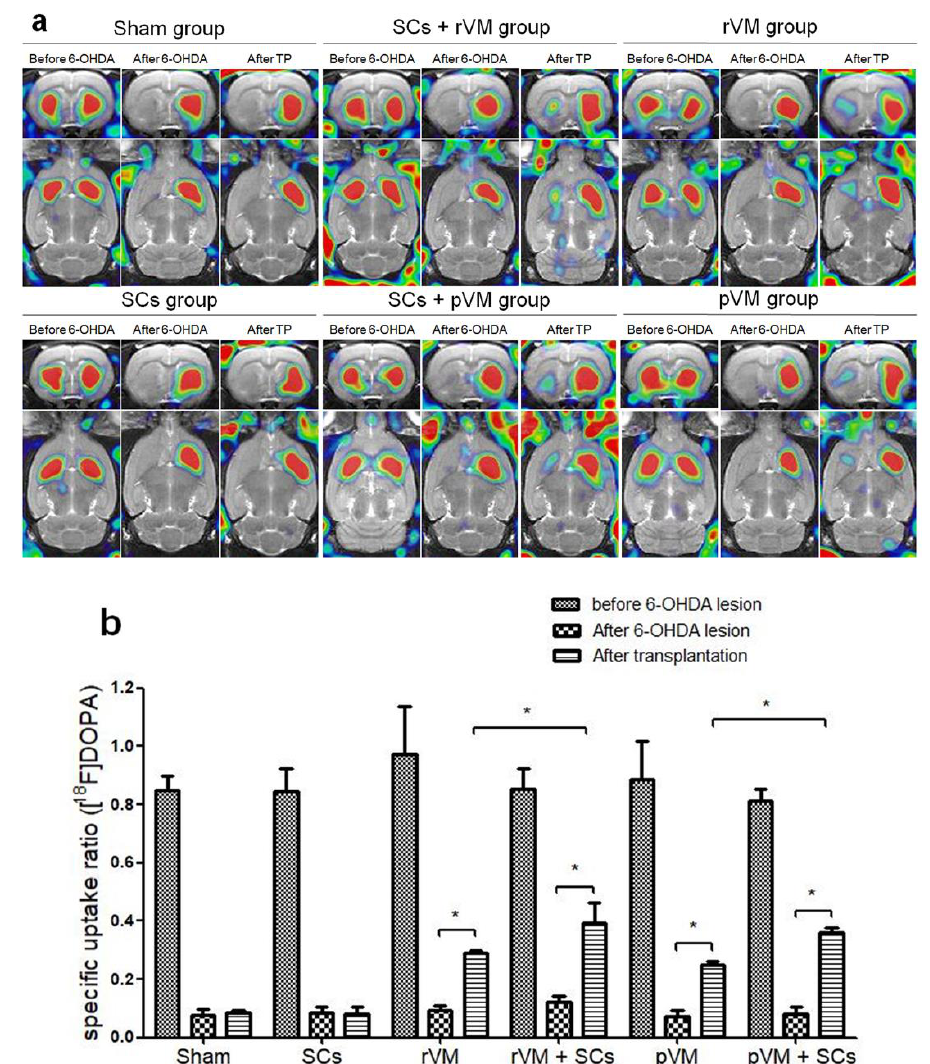
Figure 4. PET images of 18 F-DOPA uptake distribution in rat brains. ( a ) Coronal (upper panel) and horizontal (lower panel) sections of each group were acquired 50 – 80 min after injection of 18 F-DOPA. Left, middle, and right columns of each group represent the 18 F-DOPA uptake before the 6-OHDA lesion, after the 6-OHDA lesion, and after transplantation with different grafting materials, respectively. ( b ) Specific uptake ratios (SURs) of 18 F-DOPA of the grafted striatum at different time points and under different grafting conditions (* p < 0.05).